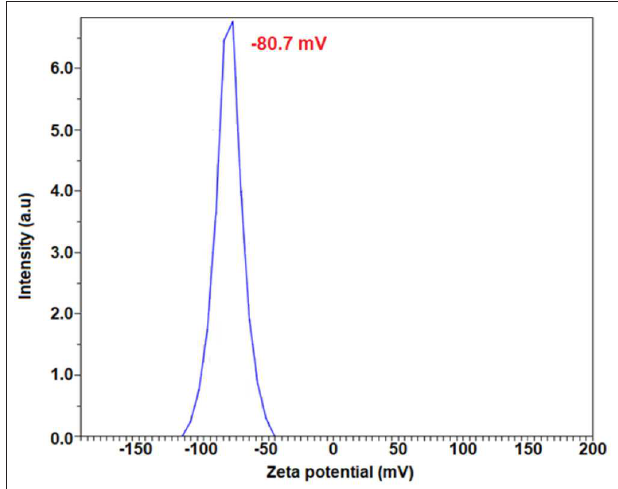
FIGURE 7 | The zeta potential result of E. spiralis extract at 2.5g E. spiralis stem powder